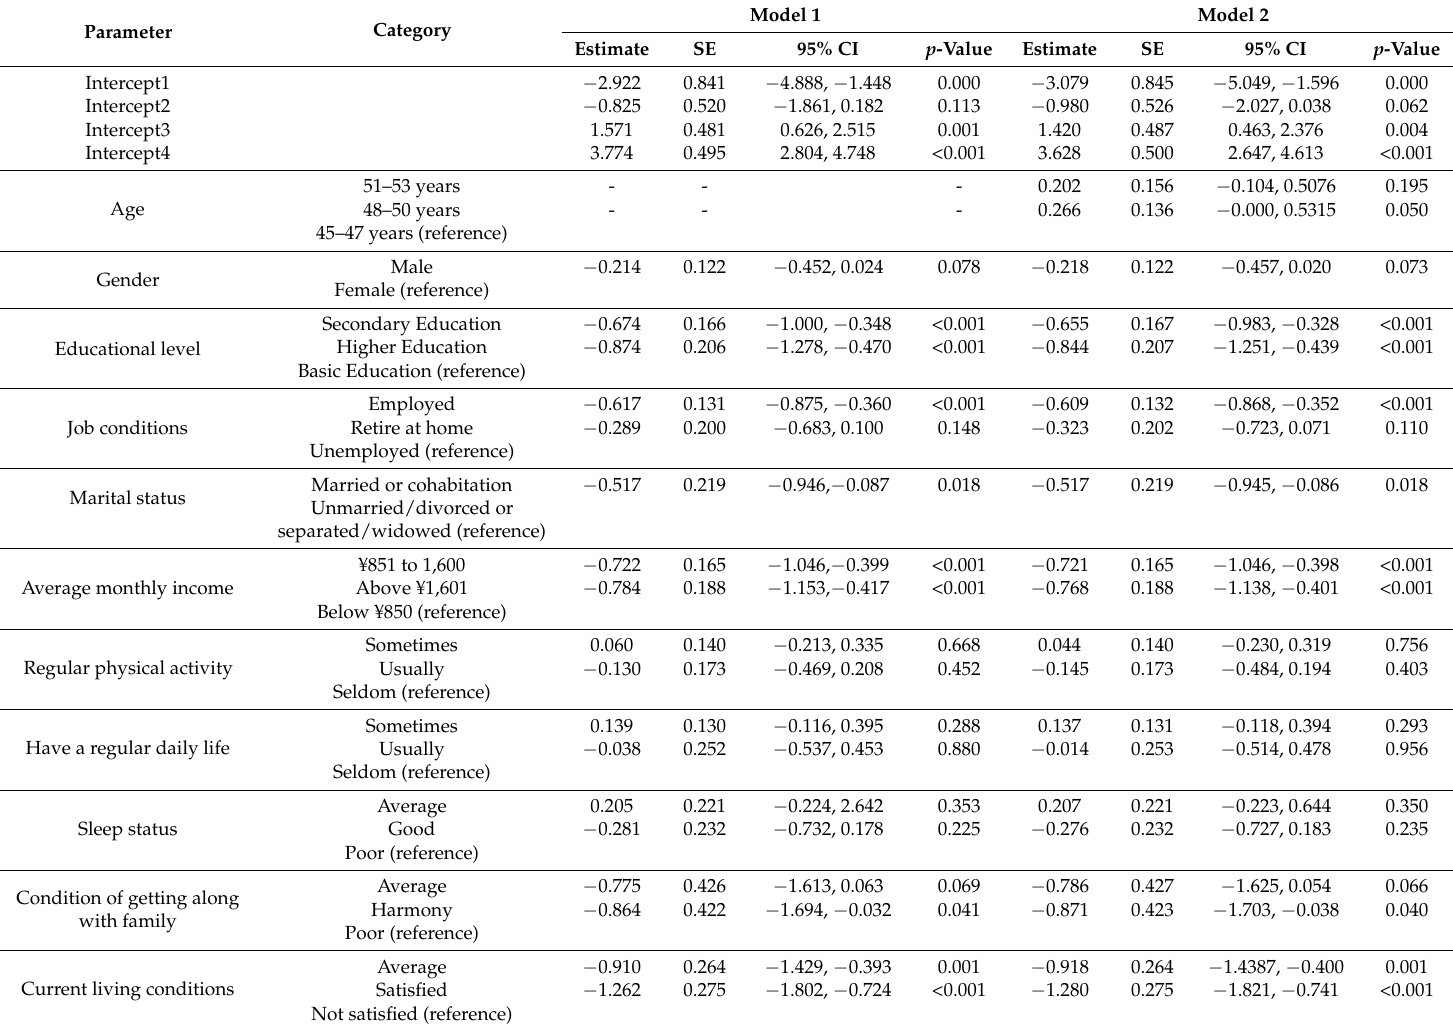
Table 3. Ordered Multivariate logistic regression analysis of body pain interference in adults (45–53 years old) in Chongqing,